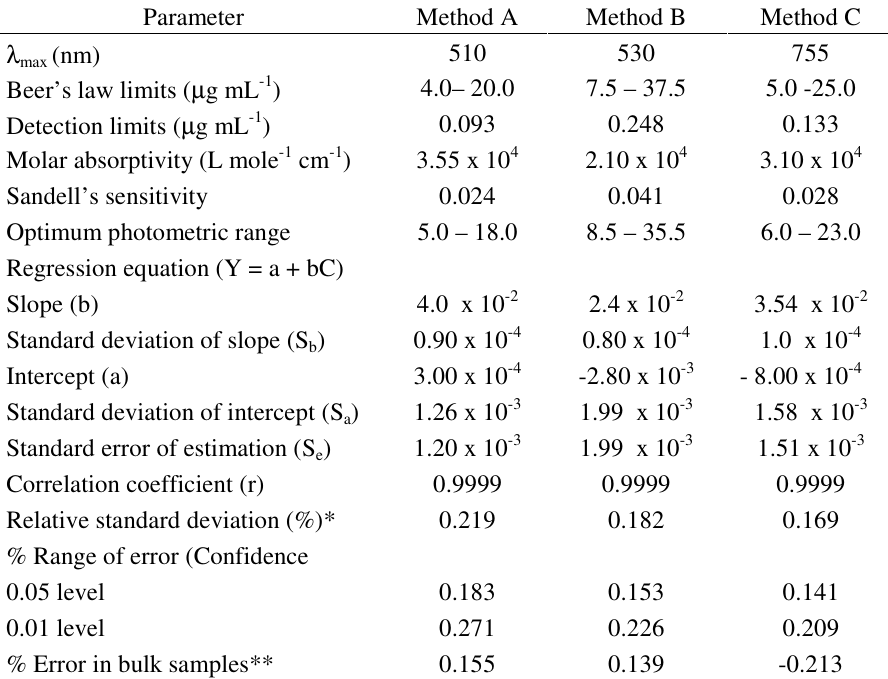
Table 1. Optical and Regression Characteristics, Precision and Accuracy of the